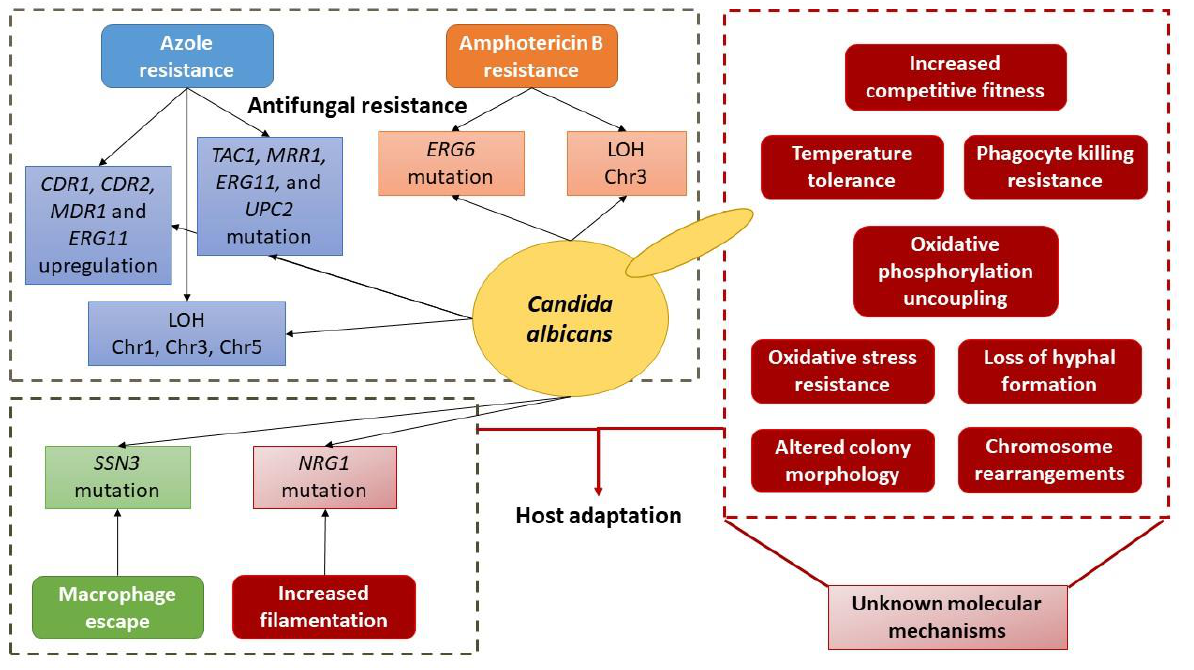
FIGURE 2: Schematic depiction of the currently known molecular basis of evolution towards antifungal resistance and host adaptation in C. albicans